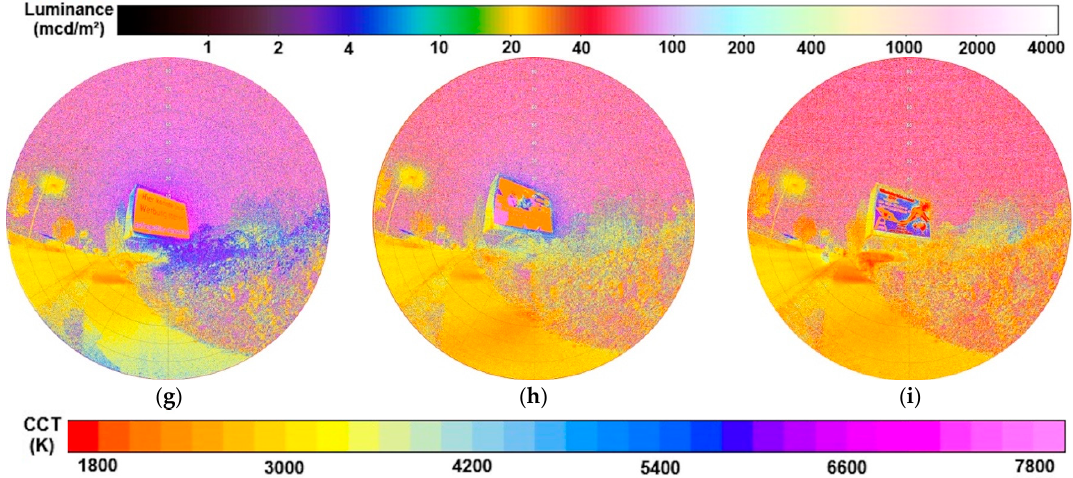
Figure 16. Raw versions and SQC products of images of a LED video wall, all taken on 24.10.2019, 21:09 h with different advertisements: ( a – c ) show the raw images captured, ( d ) and ( g ) show luminance and CCT values of advertisement 1, ( e ) and ( h ) of advertisement 2, ( f ) and ( i ) of advertisement 3. Please note a higher CCT scale up to 7800 K.